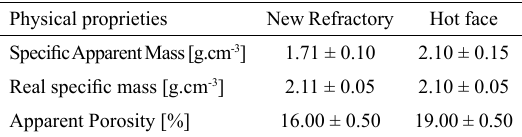
Table 3. Physical proprieties of the samples collected from the Region between the Tap Holes with standard deviation. Physical